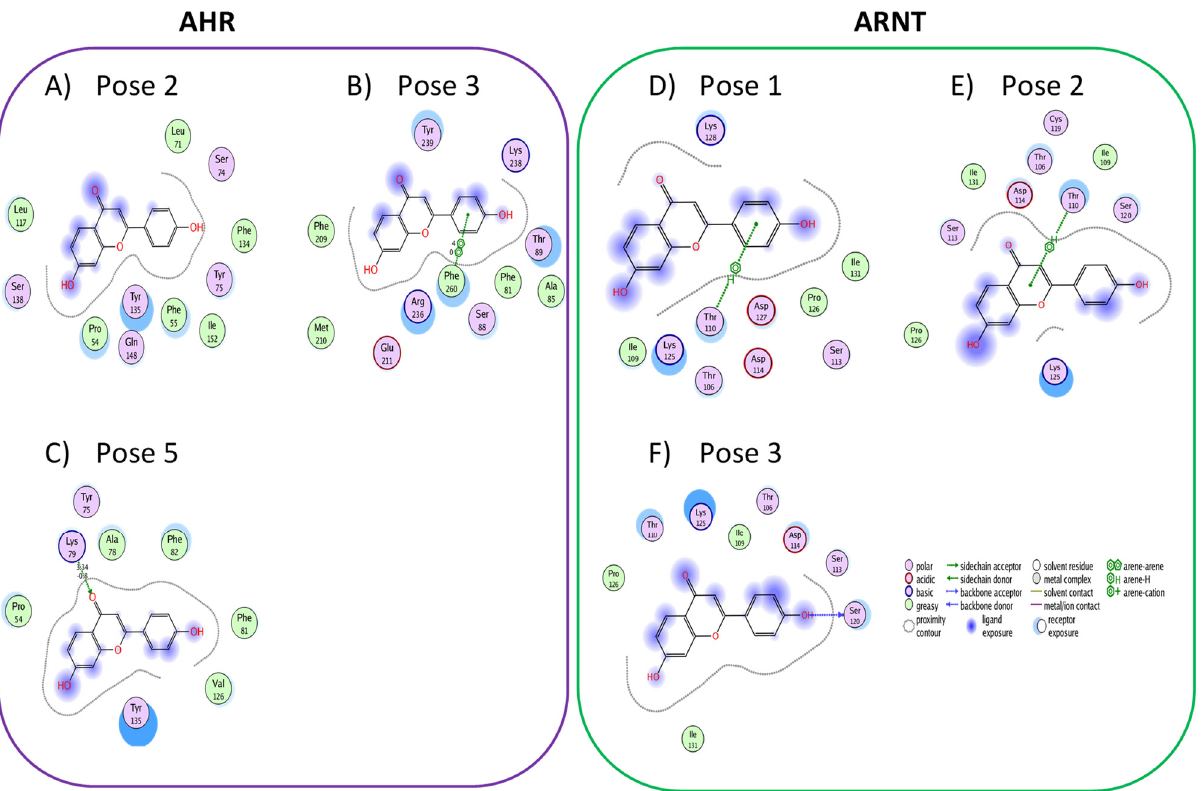
Figure 6. Interaction network between monomeric proteins AHR, ARNT and the studied compound 1 .